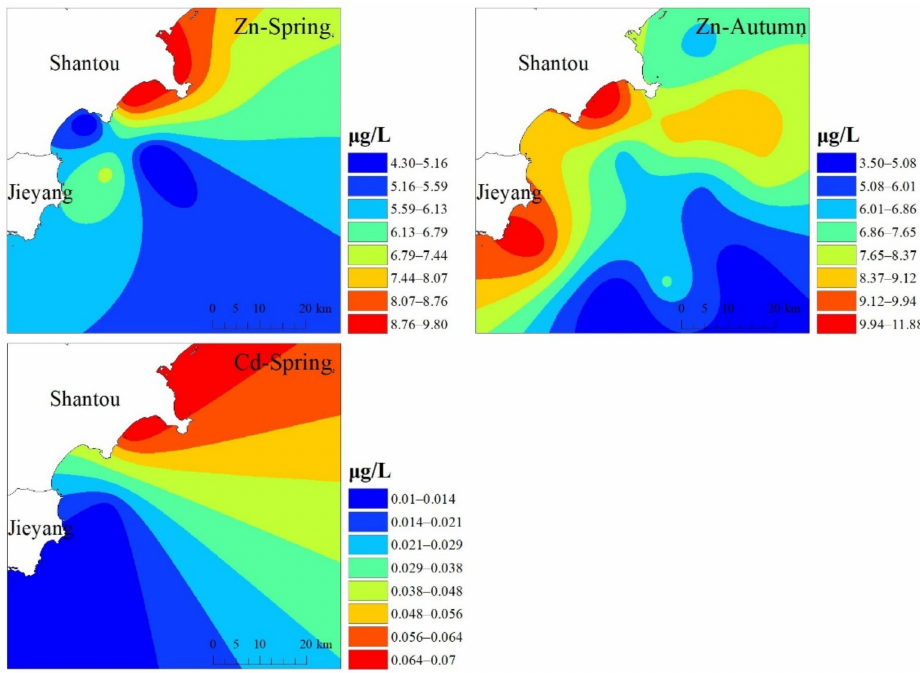
Figure 2. The spatial distribution of heavy metals in